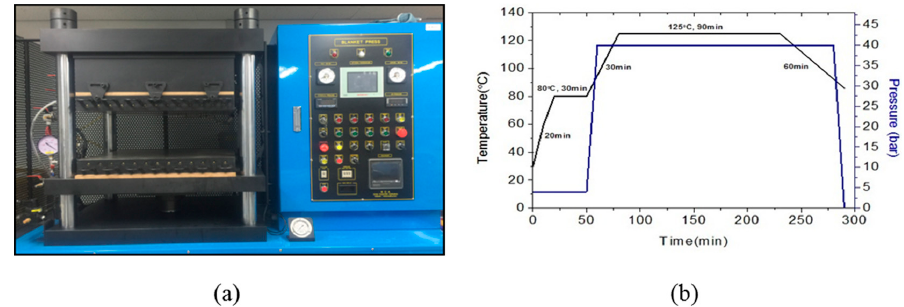
Figure 1. The set-up for specimen manufacturing: ( a ) autoclave machine, and ( b ) curing cycle of carbon-fiber-reinforced plastic (CFRP) stacking specimen.